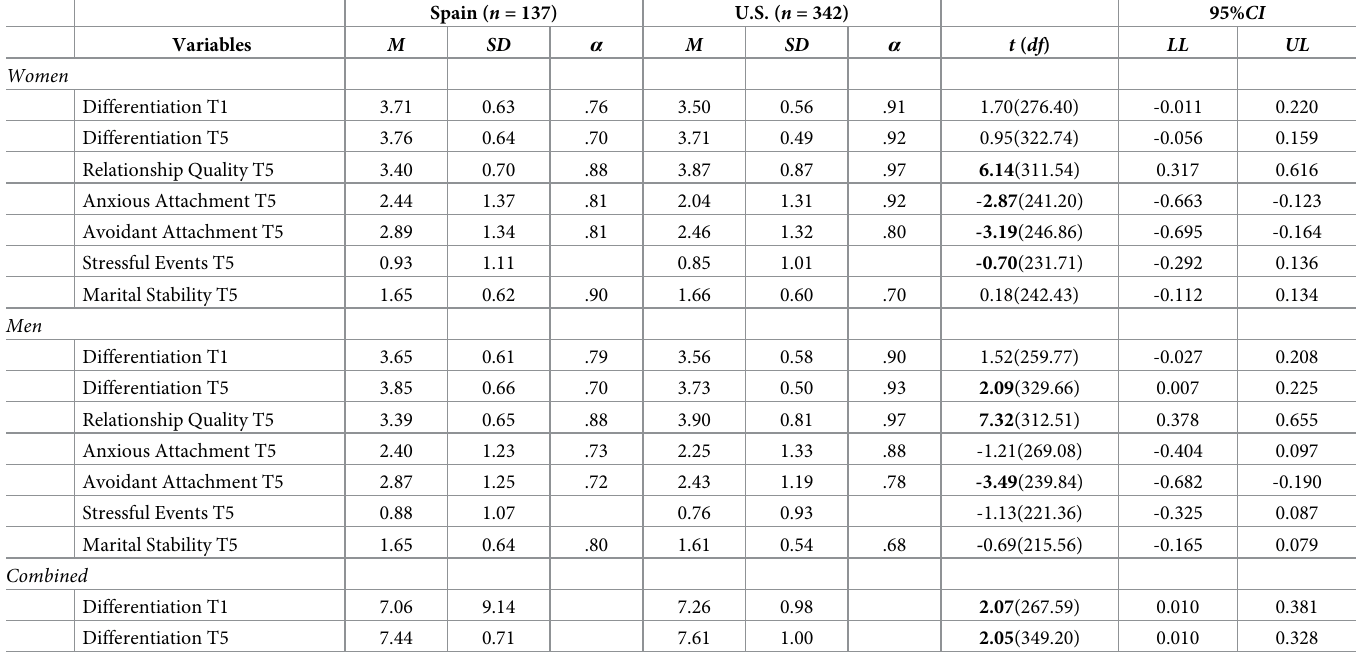
Table 3. Descriptive statistics for U.S. and Spanish couples and comparisons of means across cultures with independent samples T-tests. Spain ( n =